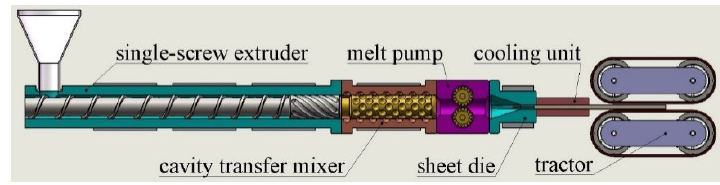
Figure 1. Schematic diagram of the single‐screw extruder foaming system.